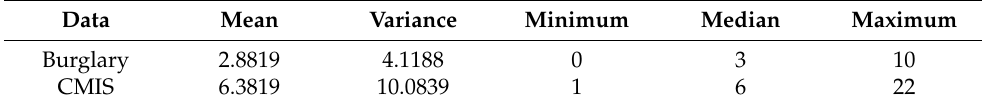
Table 6. Summary statistics for the monthly number of burglaries and CMIS in beat 11. Data